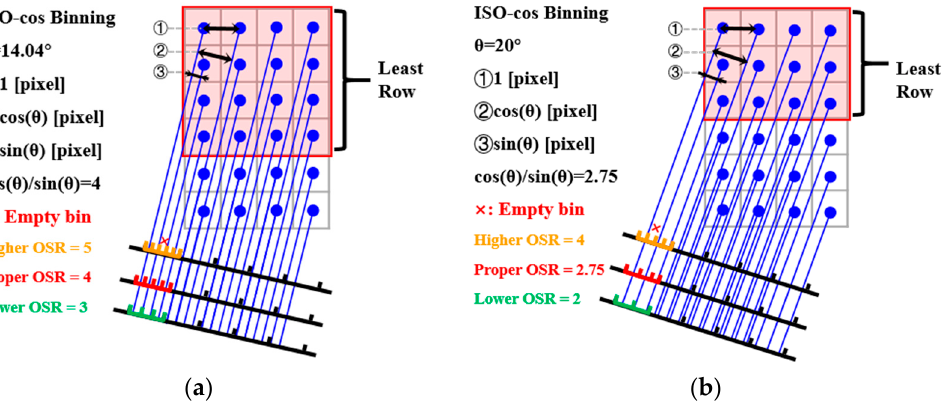
Figure 8. Diagrams of OSR determination when edge angle differs: ( a ) when edge angle is 14.04 deg, ( b ) when edge angle is 20 deg.